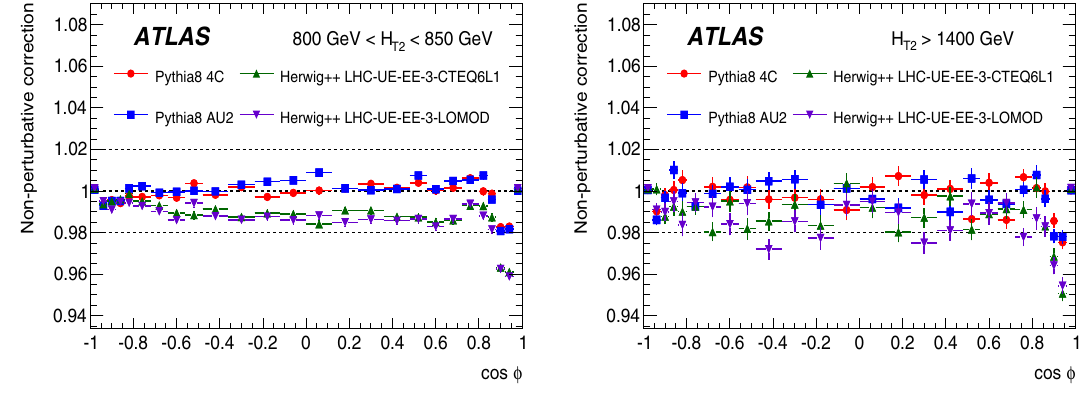
Fig. 5 Non-perturbative correction factors for TEEC in the first and last bins of H T2 as a function of cos φ